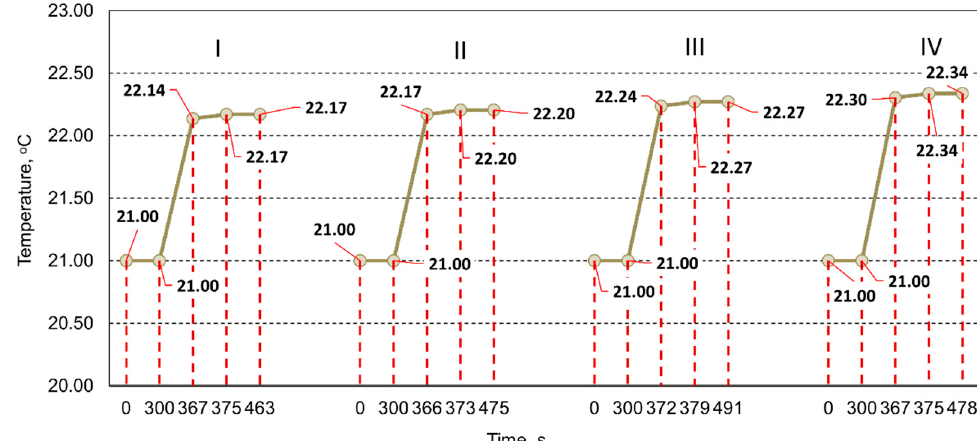
Figure 10. Characteristics of the combustion temperature of a sample of a spruce tree conditioned with a pulsed electric field: I (electric field intensity 25 kV · cm − 1 and number of pulses 150); II (electric field intensity 25 kV · cm − 1 and number of pulses 300); III (electric field intensity 30 kV · cm − 1 and number of pulses 150); IV (electric field intensity 30 kV · cm − 1 and number of pulses 300).